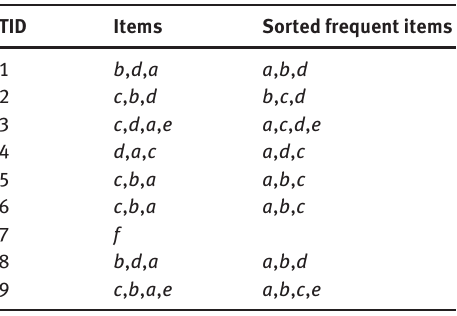
Table 2. Sample Data Set with Minsup =